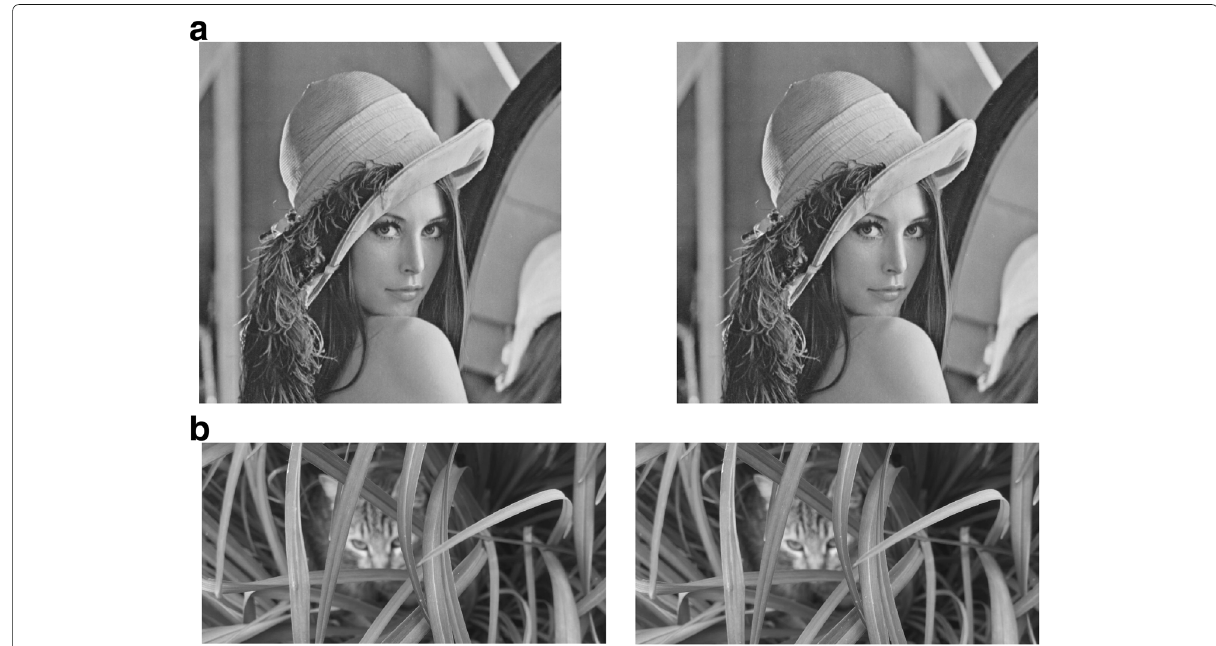
Fig. 3 Embedding 64 bits in the DCT domain. a N = 64, PSNR = 56.10 dB. b N = 312, PSNR = 63.74